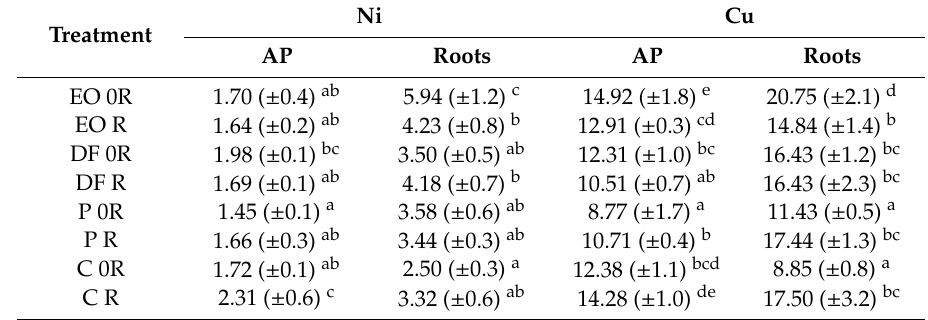
Table 6. The e ff ect of petroleum-derived substances and bioremediation on the content of nickel and copper in the aboveground parts (AP) and roots of Vicia faba L. (mg kg − 1